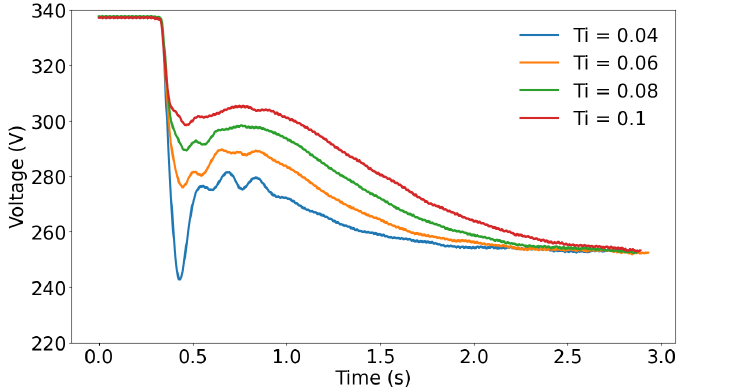
Figure 19. System voltage signal at the starting phase with K p = 2 and different T i .